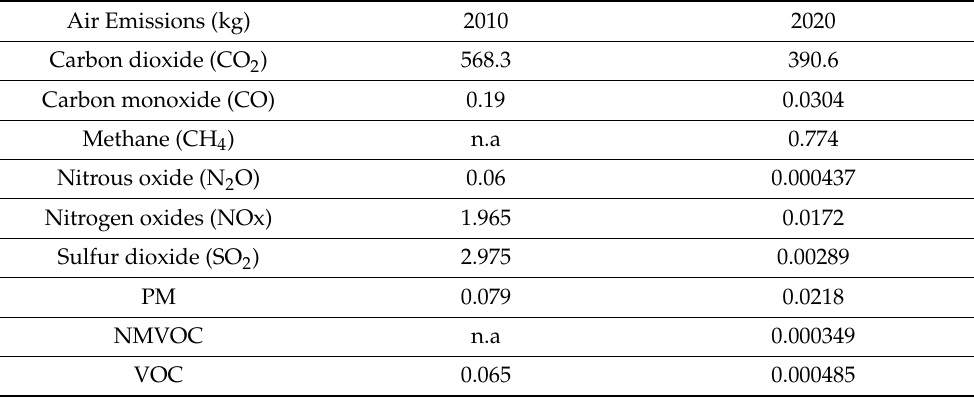
Table A3. Cradle-to-gate LCI for 1 MWh.